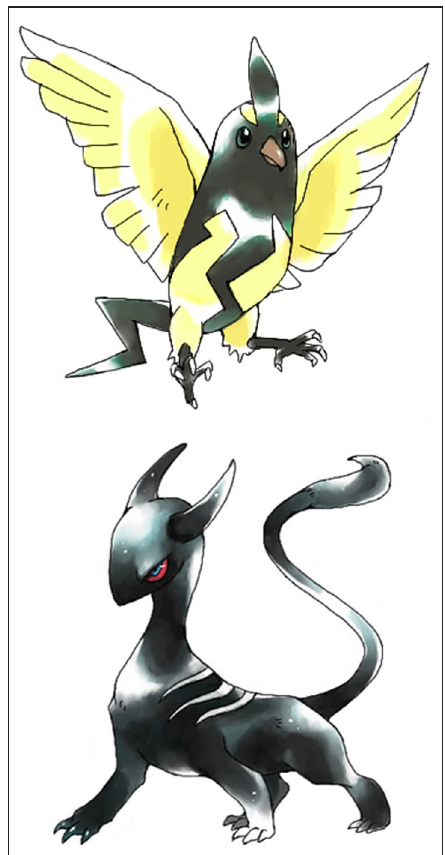
Figure 1: Example of flying (top) and evil (bottom) Pokémon used in Experiment 1; pictures were presented